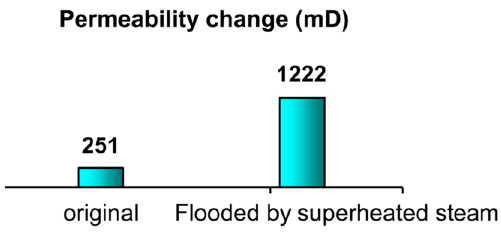
Fig. 3 Increase of the permeability of reservoir (Xu et al.